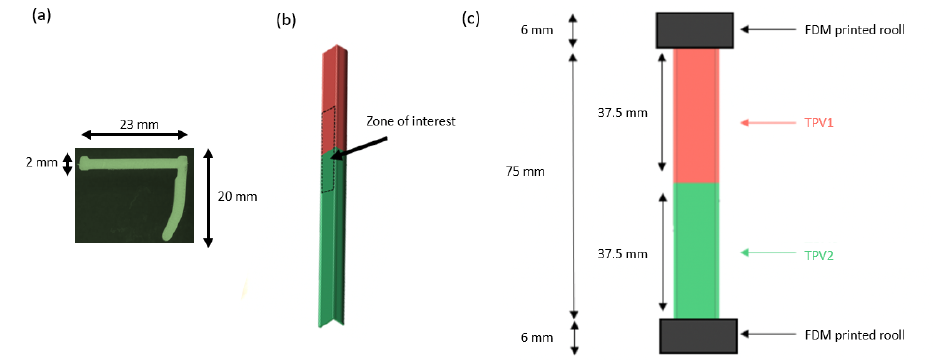
Figure 2. ( a ) Cross-section of the profile. ( b ) Zone of interest centred on the interface. ( c ) Dimensions of the specimens. FDM printed rolls of 6 mm diameter were glued to the ends of the